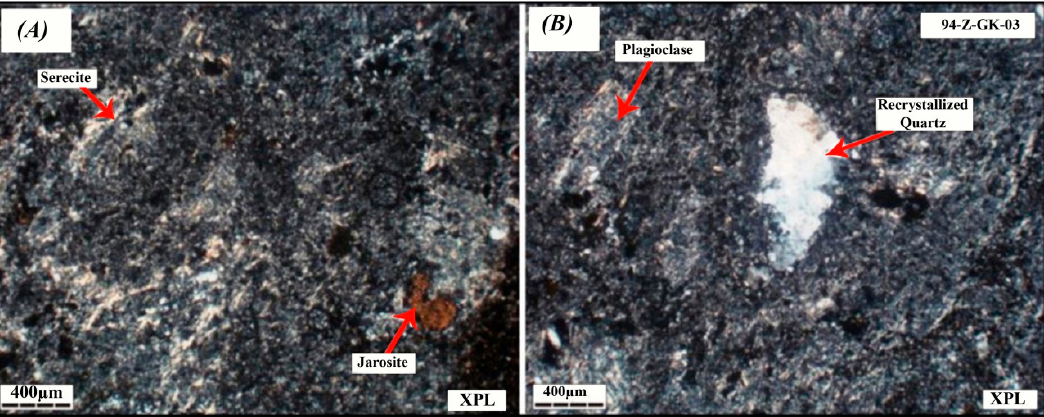
Figure 15. Microphotographs of argillic-silica alteration. ( A ) Original mineralogy (feldspars) replaced by sericite, jarosite and clay minerals; ( B ) Recrystallized large-grained quartz and relics of plagioclase in the background of clay minerals.